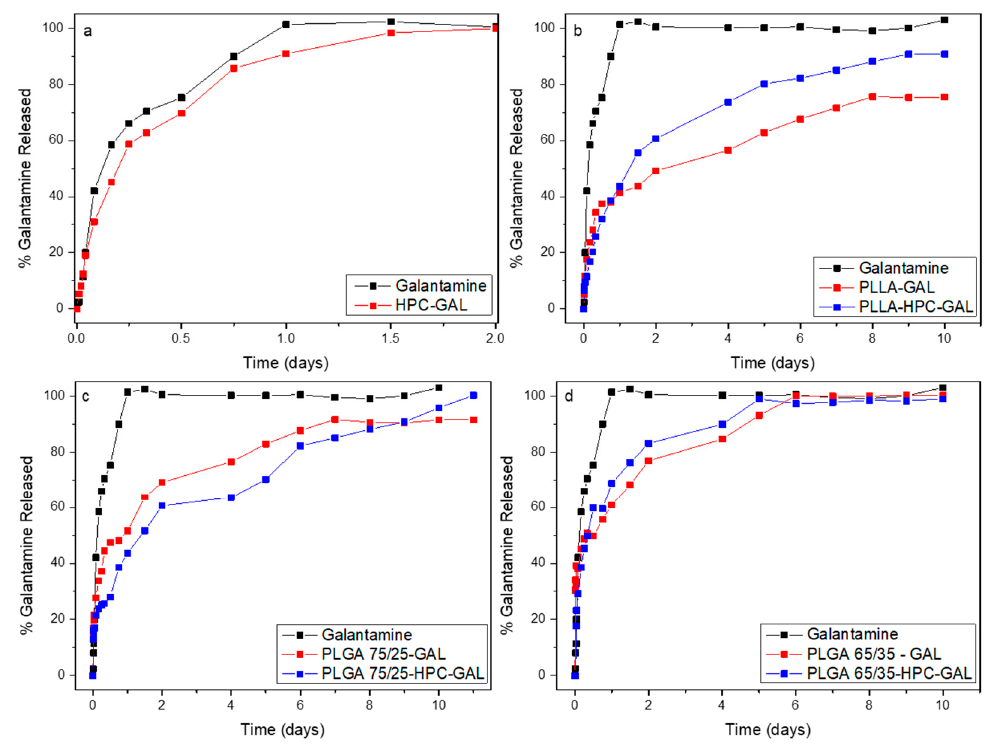
Figure 11. In vitro galantamine release profile. ( a ) Gal and HPC-GAL; ( b )PLLA nanoparticles; ( c ) PLGA 75/25 nanoparticles; ( d ) PLGA 65/35 nanoparticles.